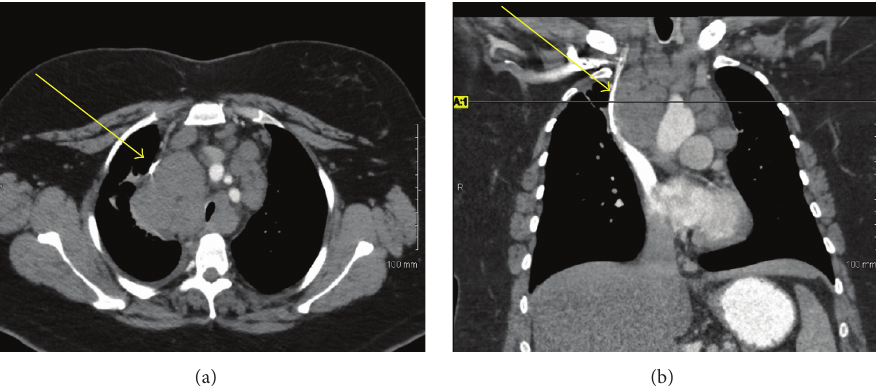
Figure 2: Axial (a) and coronal (b) chest CT images showing mediastinal lymphadenopathy compressing the SVC (arrows) and trachea. The axial image in (a) is at the level of the horizontal line noted in